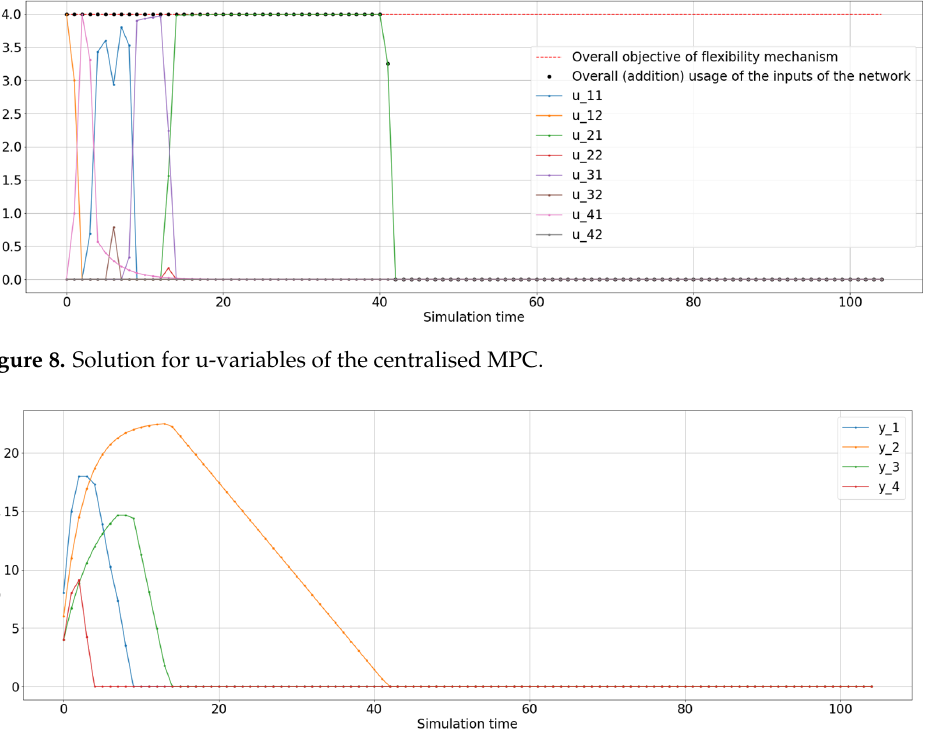
Figure 9. Solution for y-variables of the centralised MPC.